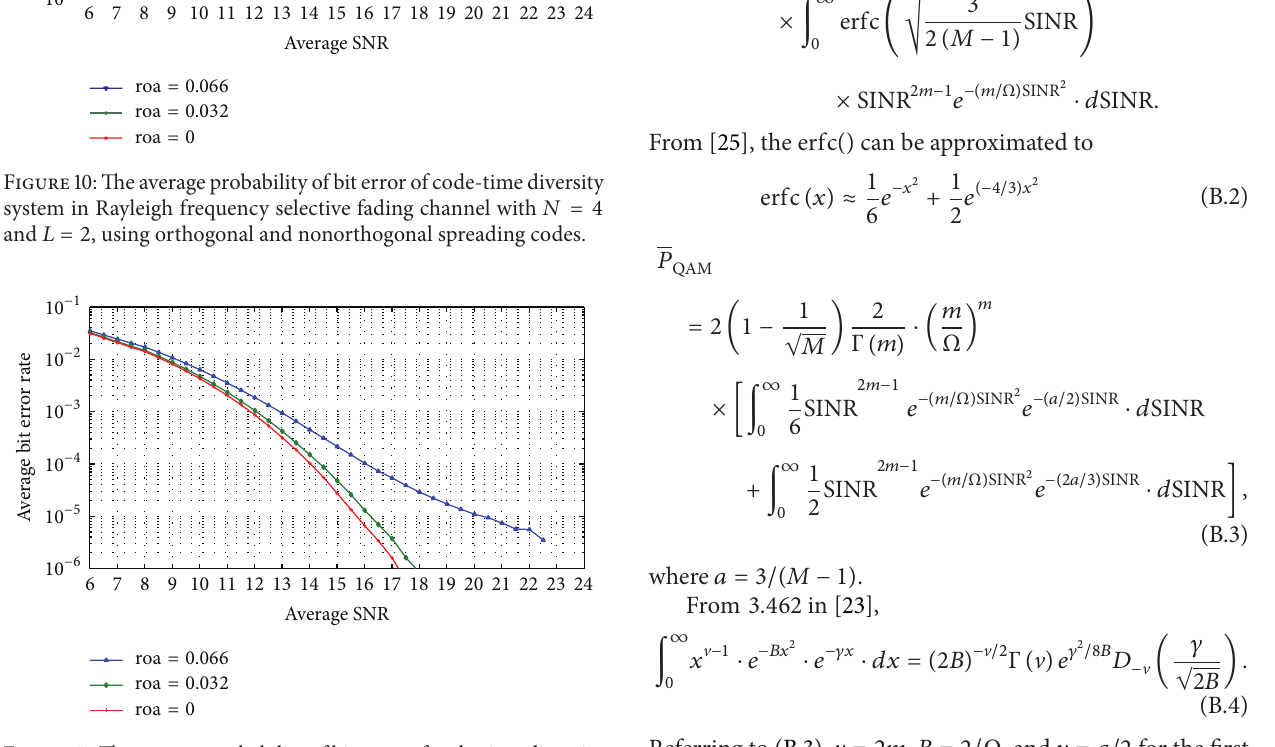
Figure 11: The average probability of bit error of code-time diversity system in Rayleigh frequency selective fading channel with 𝑁 = 4 and 𝐿 = 4 , using orthogonal and nonorthogonal spreading